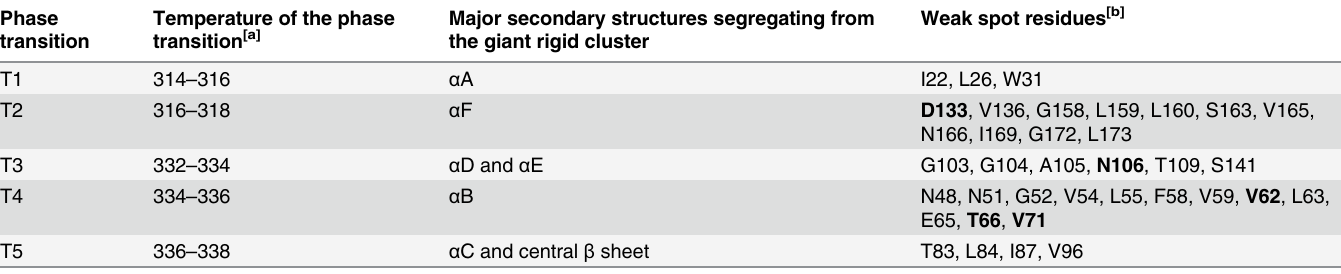
this procedure yielded a predicted thermostabilization with respect to WT Bs LipA for 75 out of the 522 mutations (~14%) investigated. In order to further reduce the number of mutations for was chosen from all mutations experimental validation only the mutation with the highest Δ T p > 1 K at a weak spot. The sole exception is G104 located in the active site, for which with Δ T p two mutations were chosen. This resulted in twelve lipase variants of which the most are associ- ated with weak spot residues on helix α B identified during the late transition T4 (Table 2; S1 Fig). , i.e., where a mutation As a negative control, we also predicted 10 variants with negative Δ T p according to the thermal unfolding simulations leads to a decrease in thermostability with respect to WT (S1 Table). Six of these mutations were chosen from the above analyses of 522 ; four were chosen with the most negative variants such that they have the most negative Δ T p Δ T from analyses of variants with a mutation not at a weak spot. p Table 2. Bs LipA variants with positive Δ T p characterized experimentally.